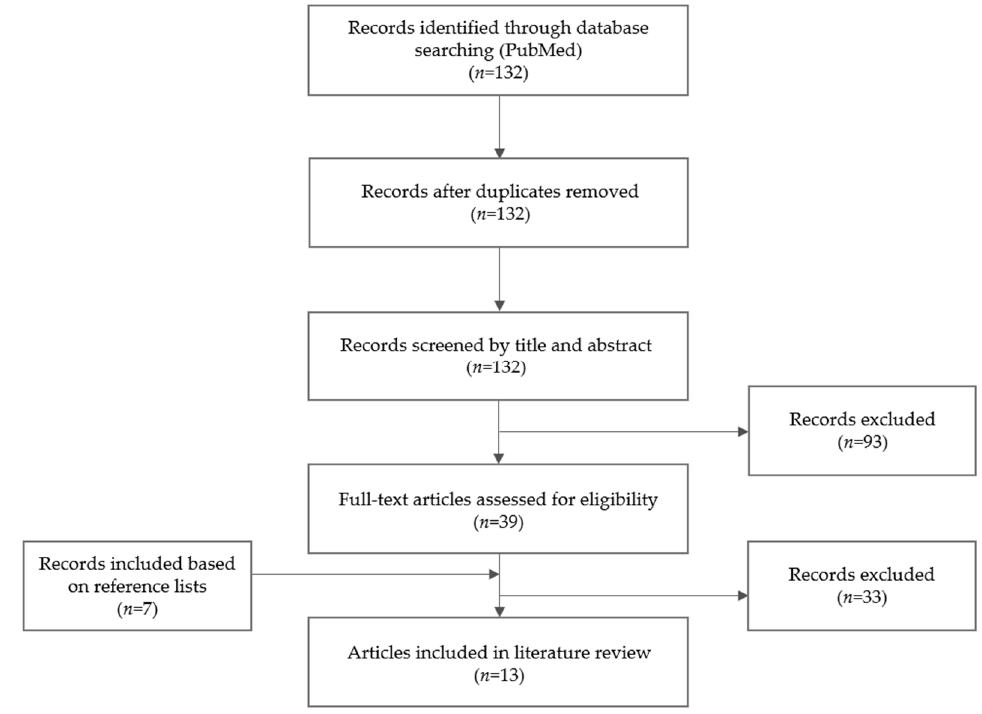
Figure 3. Selection process of articles on the bone penetration of antifungal agents.